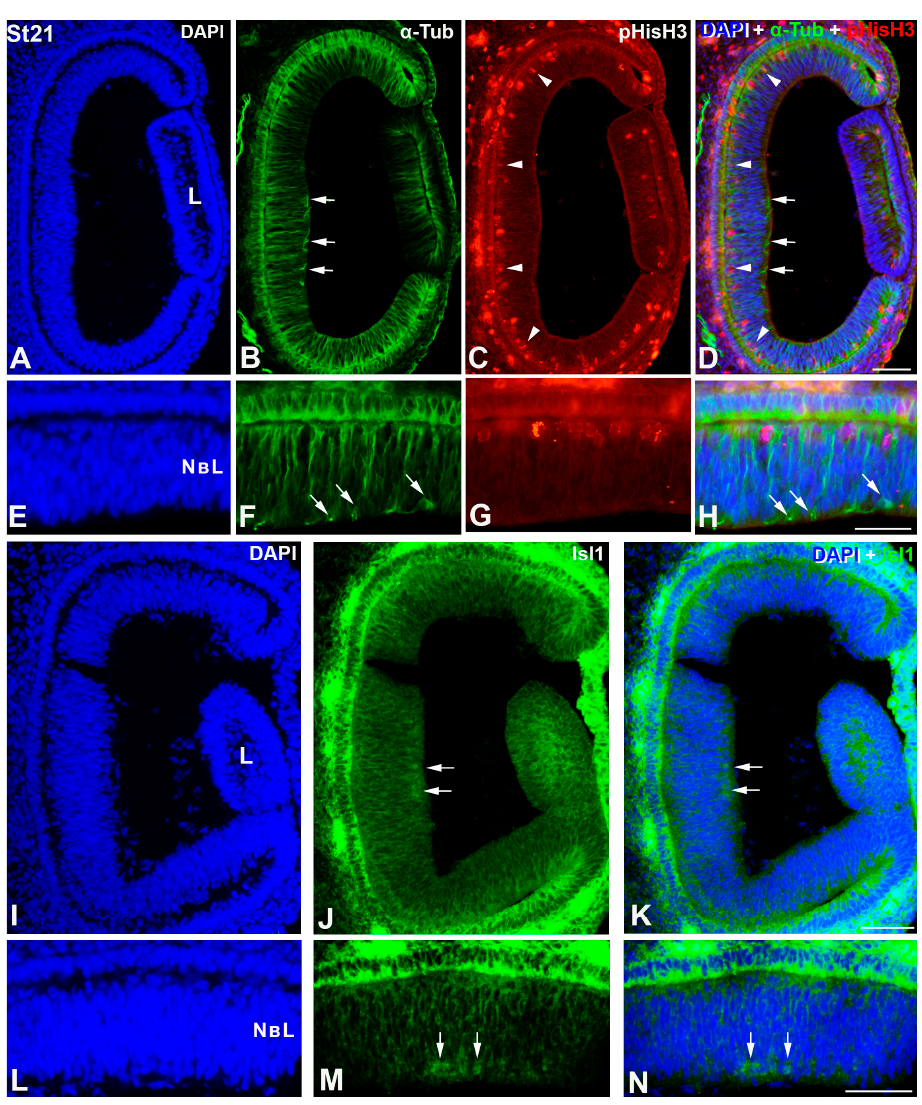
Figure 1. Onset of cell differentiation in the retina of C. corturnix at St 21- of development. DAPI staining reveals that quail retina is composed of a NbL at this stage ( A , E , I , L ). The first α -Tub-positive cells are detected at this stage in the inner surface of the neural tissue (arrows in B , D , F , H ). Radially oriented α -Tub-immunoreactive elements are also observed ( B , D , F , H ). pHisH3 antibody shows abundant mitotic cells distributed throughout the scleral surface of the NbL (arrowheads in ( C , D , G , H )). Isl1-immunoreactivity is observed in cell nuclei located in the inner surface of the NbL. These Isl1-positive nuclei are restricted to the central region of the undi ff erentiated retina (arrows in ( J , K , M , N )). L, lens; NbL, neuroblastic layer. Scale bars: 100 µm.